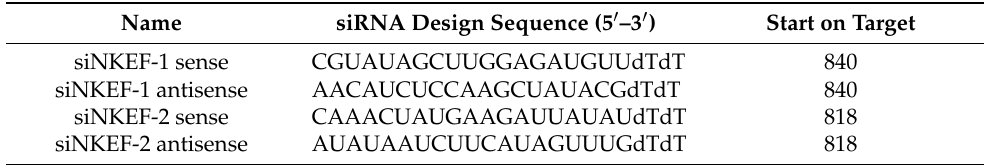
Table 1. Sequences of rainbow trout nkef -specific